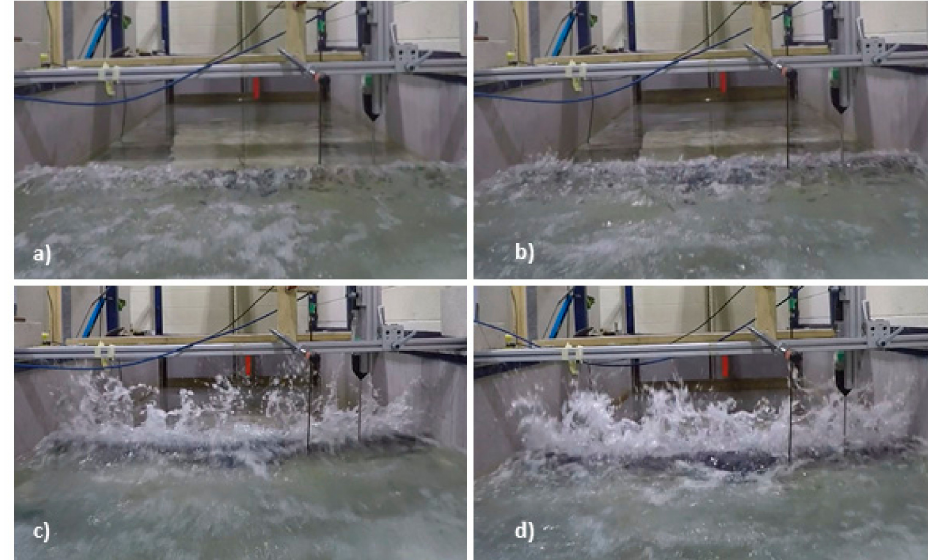
Figure 17. Water level rise at the time of bore impact, wet bed condition, and h = 40 impoundment depth cm ( a ) d / h = 0.425, S / D = 1, ( b ) d / h = 0.3, S / D = 0.6, ( c ) d / h = 0.2, S / D = 0.2, ( d ) d / h = 0.2, S / D =